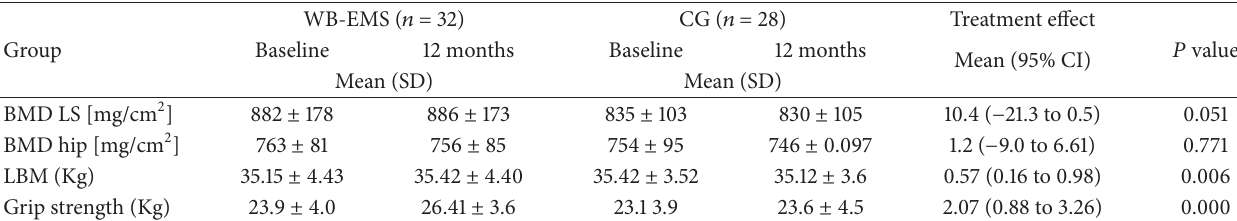
Table 2: Baseline and follow-up data of the WB-EMS and CG group for BMD lumbar spine (LS), total hip, lean body mass (LBM) and grip strength, absolute treatment effects between training and control, and 𝑃 value (covariance analysis, baseline value, age, height, lean body mass, and fat